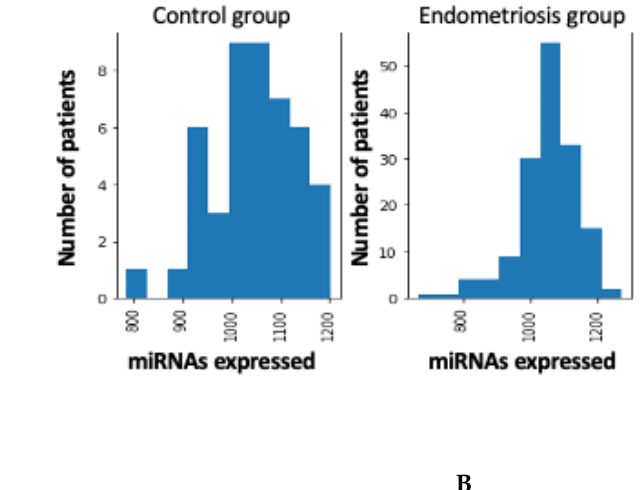
Figure 1. ( A ) Distribution of expressed miRNAs in the 200 blood samples. ( B ) Distribution of expressed miRNAs in the samples diagnosis.